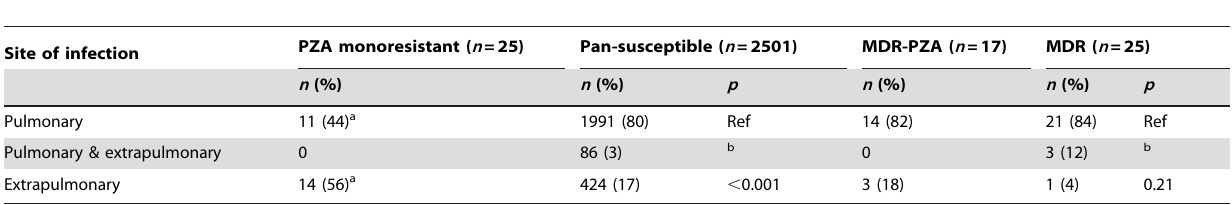
Table 1. Site of infection based on tuberculosis drug resistance pattern in San Francisco between 1991 and 2011.